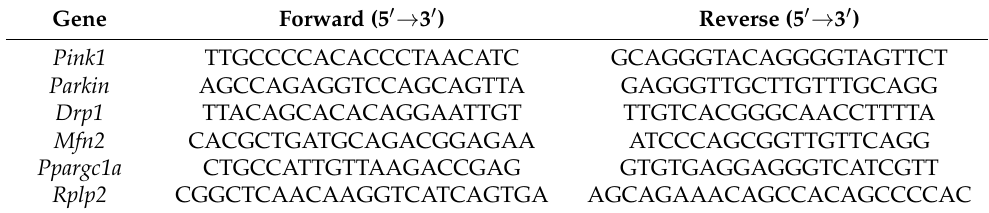
Table 3. List of gene-specific primers for RT-PCR